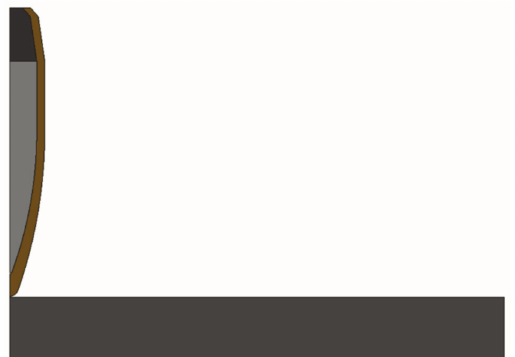
Figure 6. Geometry of the numerical model (target S is shown).